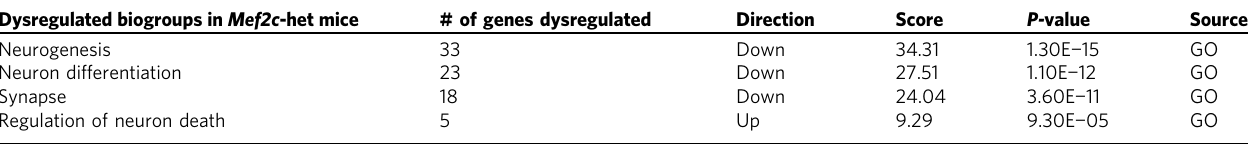
Table 1 Pathway analysis of all genes with altered expression in Mef2c -het mice Dysregulated biogroups in Mef2c -het mice # of genes dysregulated